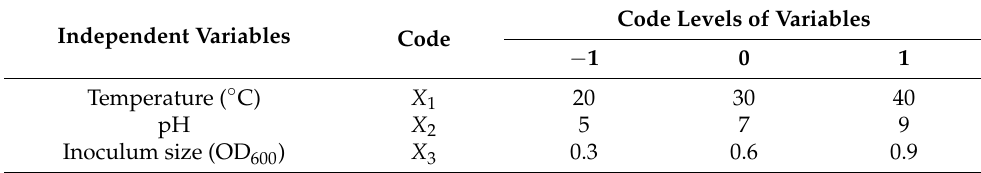
Table 5. The code and levels of three independent variables used in Box–Behnken design. Independent Variables